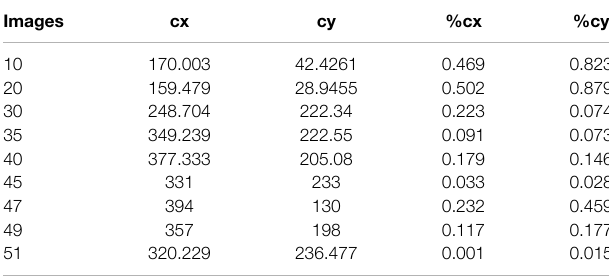
TABLE 1 | Comparative table between the centers of the real image and those of the matrix (the best results achieved are highlighted in red). Images cx cy